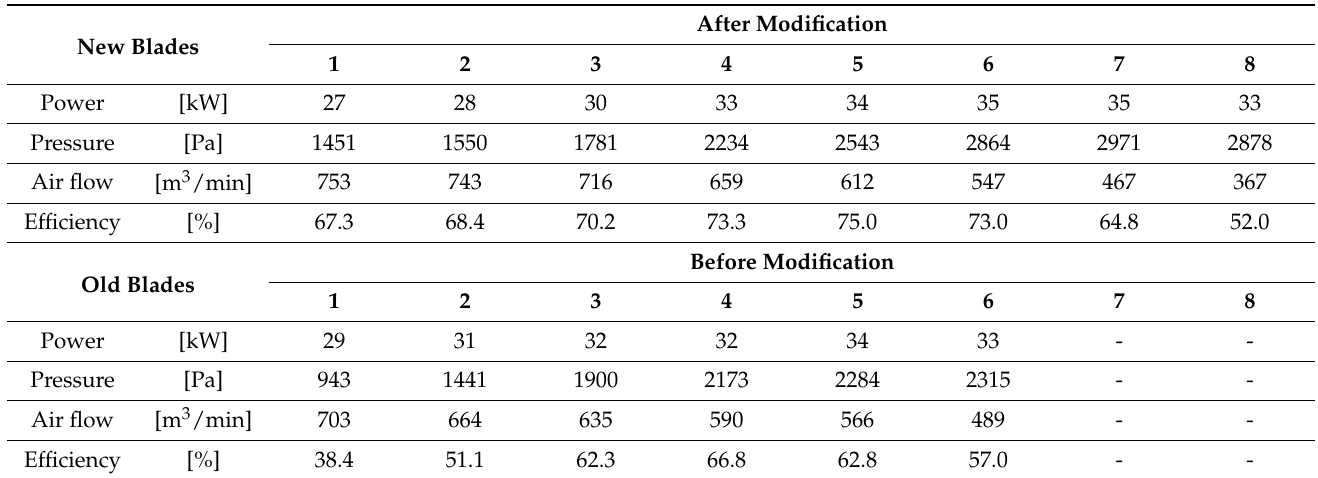
Table 4. Comparing the results before and after modification of the